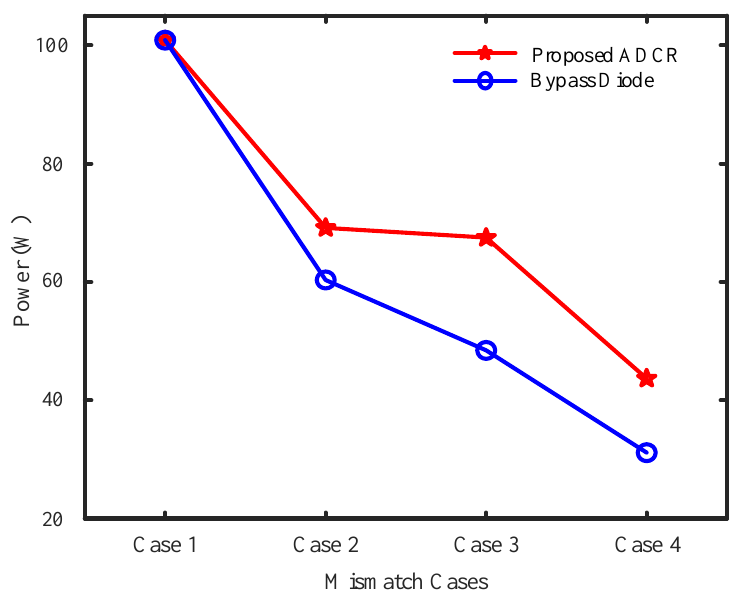
Figure 11. Power extraction under mismatch cases in Figure 9 for a PV setup using the introduced ADCR in Figure 7 and traditional bypass diode architectures.